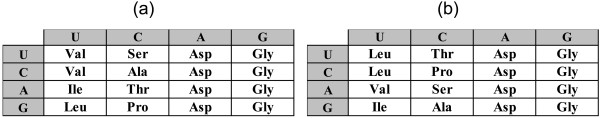
Error minimization level of 2-letter codes. Starting from a random permutation of amino acids assignments among the supercodons highlighted in Fig. 5, optimization was performed to find the least costly assignment. (a) 9 amino acids, the optimum code is shown, MP = 0.94; (b) The number of supercodons coding for Leu is fixed to 2; MP = 0.987.